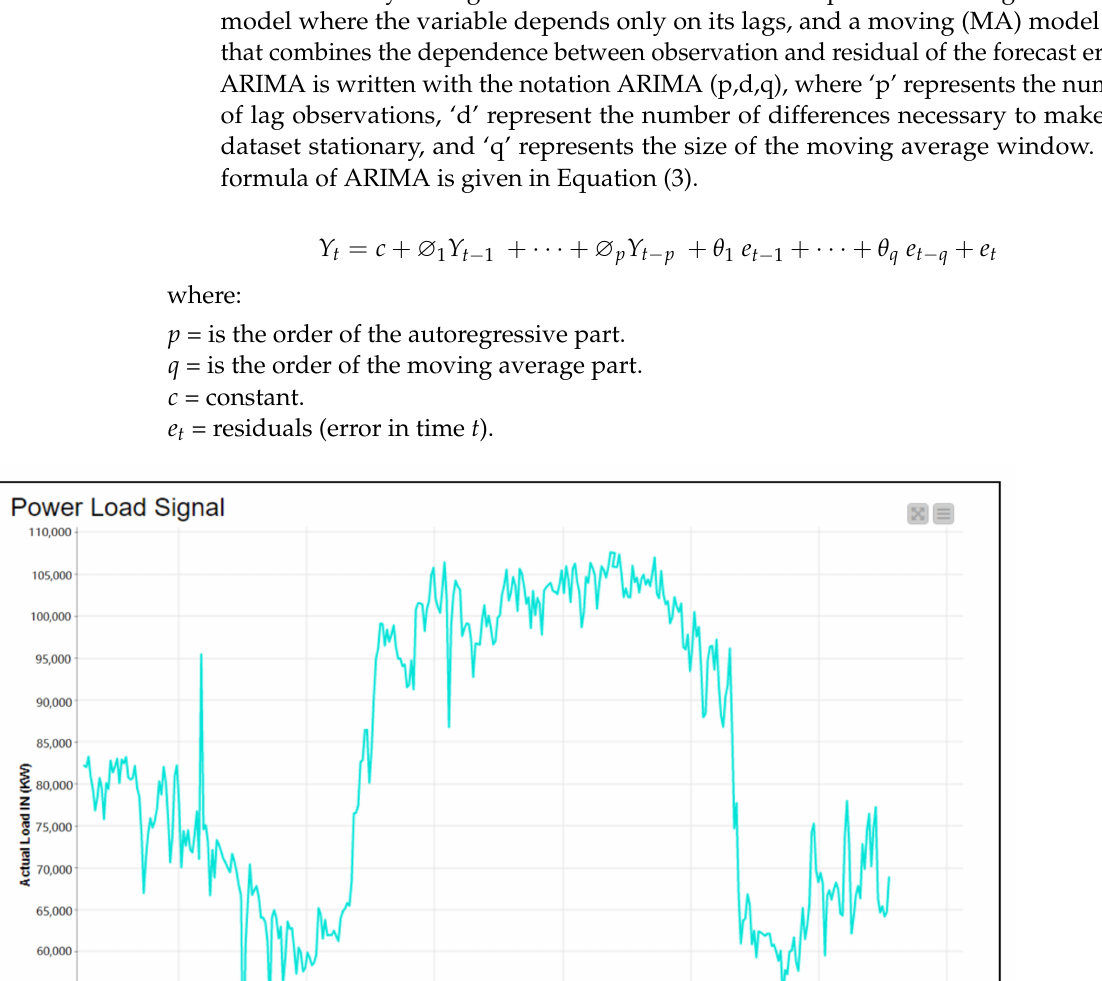
zero in the ARIMA